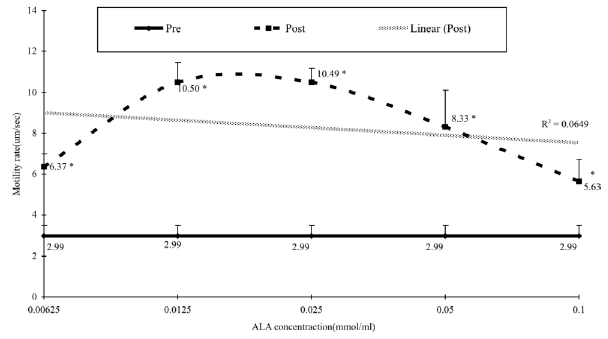
Figure 1 - Dose response curve of ALA against sperm motility. Sperm motility was assessed using light microscope with Mtrack J Imaging System on the Weber sterility chamber. Mann-Whitney t-test was used to determine the differences between baseline (pre) and after one-hour incubation (post). r 2 = 0.0649 *P<0.05.